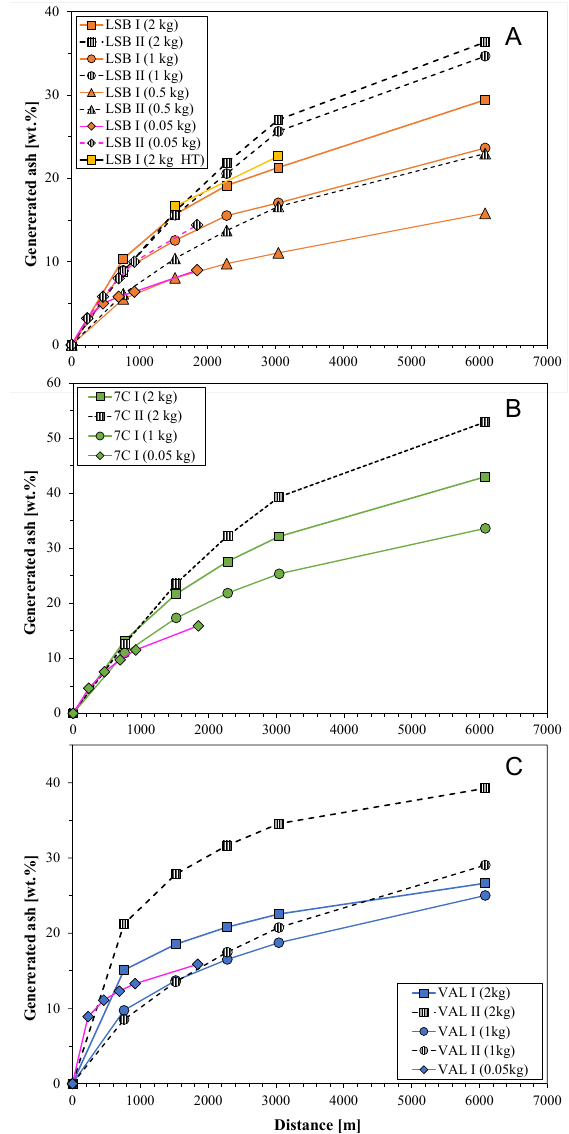
Figure 3: Ash production during tumbling experi- ments. Cumulative generation of ash (<2 mm diame- ter) is plotted as wt.% of the starting mass with rota- tional distance for all experiments using samples from [A] Laacher See (LSB), [B] Sete Cidades (7C) and [C] Valentano (VAL). Solid symbols, solid lines: type I ex- periments; black striped symbols, dashed lines: type II experiments; yellow lines and symbols: high tempera- ture data for LSB; diamond symbols, pink lines: 0.05 kg experiments, conducted in the small tumbler. As all ex- periments lasted 2 h, 0.05 kg experiments had lower to- tal tumbling distance. Type I and II experiments show substantial di ff erences for LSB and 7C, with an almost linear decrease in ash generation e ffi ciency in the lat- ter, consistent with an energy dissipating e ff ect of inter- clast ash in the bed. After 50 % transport distance, ash production was 2–3 times higher in all type II experi- ments compared to corresponding type I